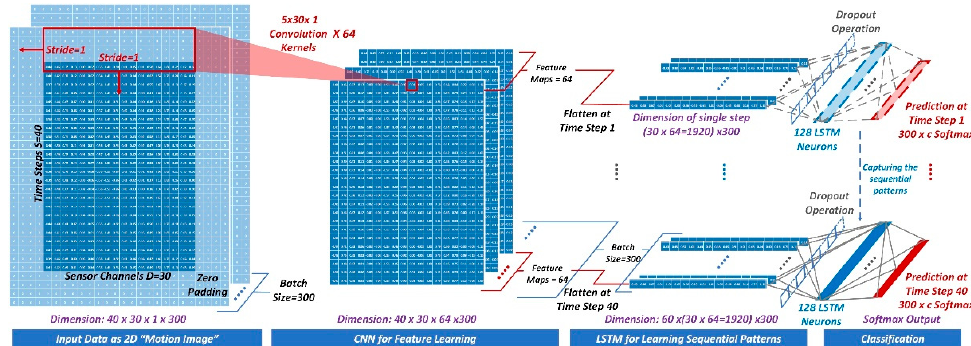
Figure 4. CLN conceptual architecture integrating one-layer CNN and one-layer LSTM. The detailed model parameter setup and evaluation is discussed in the authors’ previous work [17].